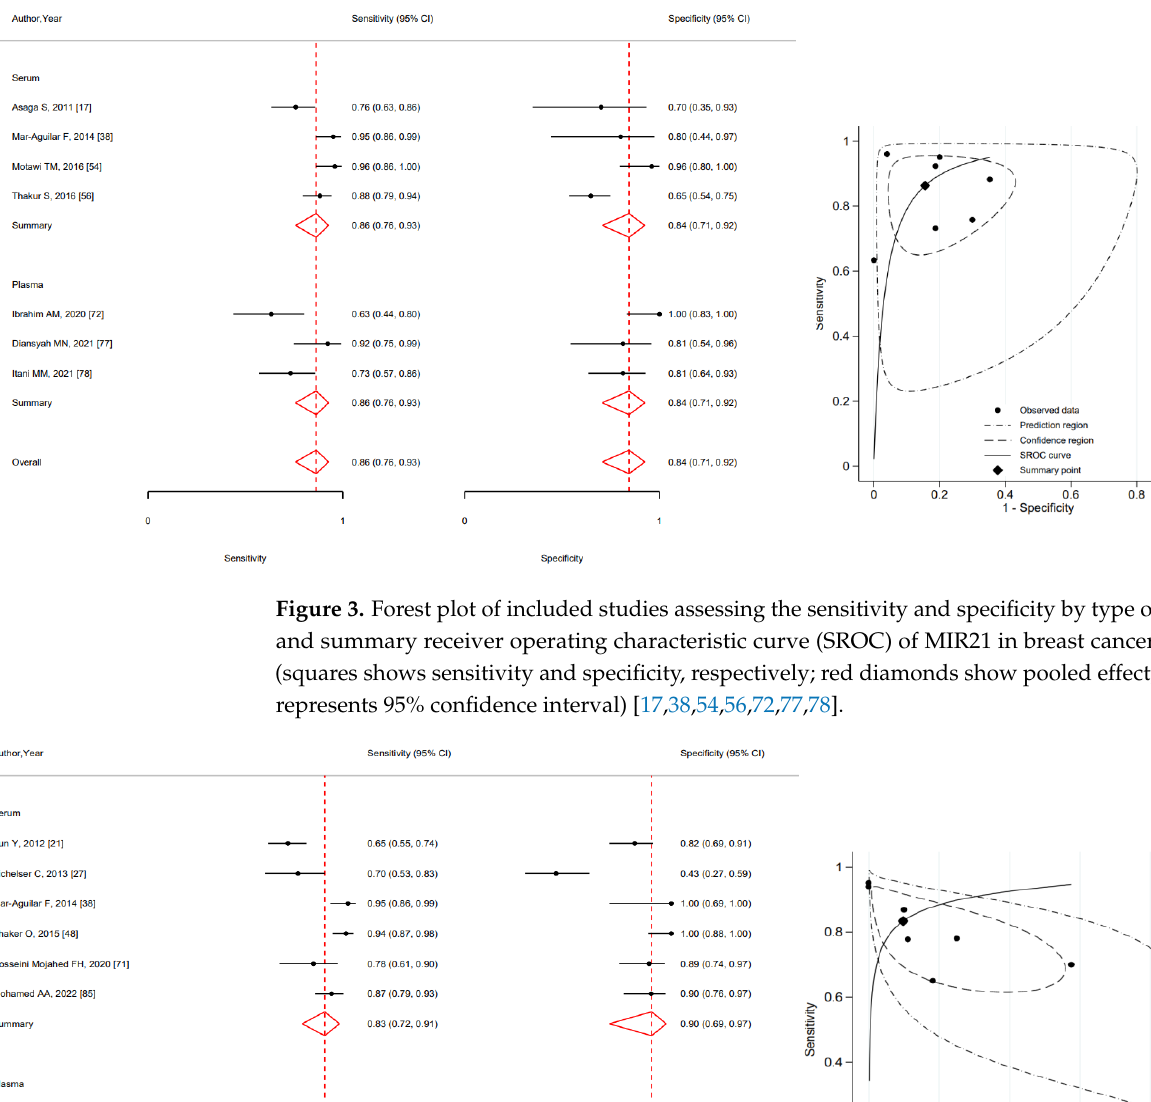
Figure 2. Pyramidal graph of the direction of miRNA expression (microRNA concentration in breast cancer cases versus controls) by type of specimens (only microRNAs that were analysed in two or